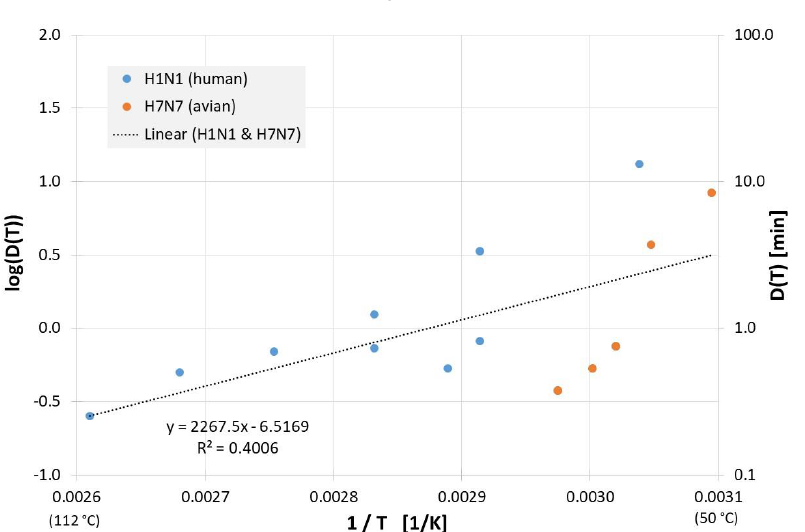
Figure 4. Correlation between 1/T and log(D(T)) for all published influenza virus thermal inactivation data in cell culture medium along with the linear regression curve. For better understanding, D(T) is also given on the right Y-axis in a logarithmic scale.